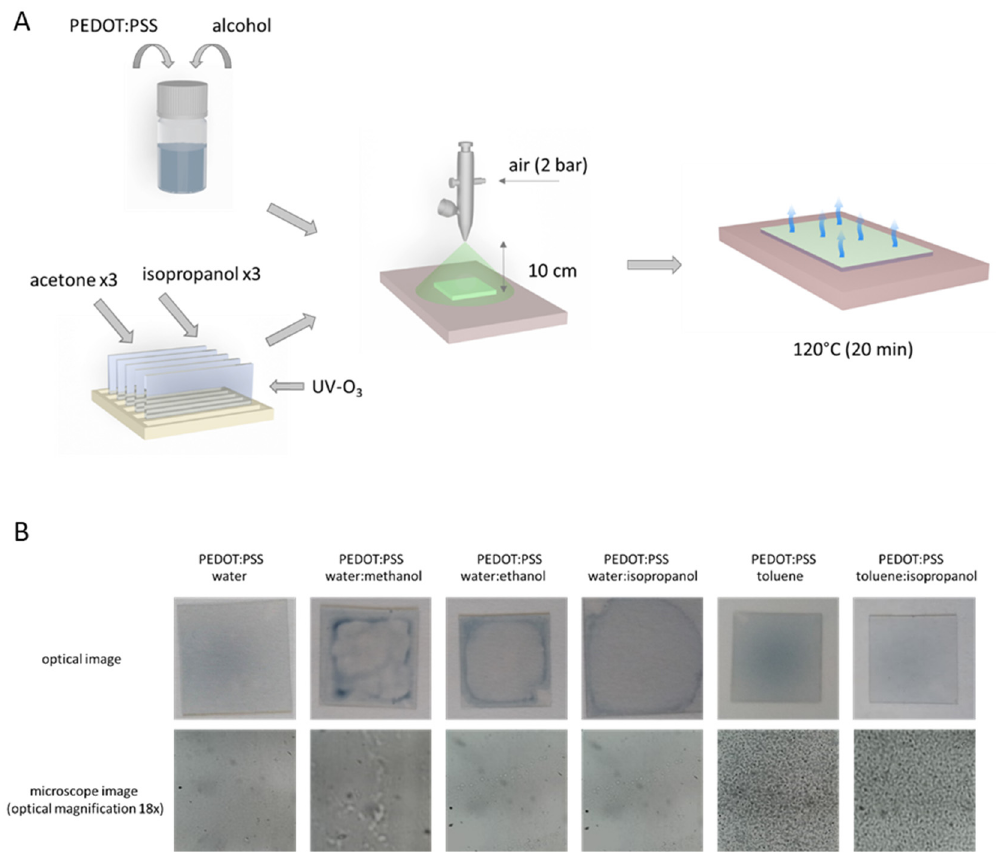
Figure 4. Scheme of layer preparation using spray coating technique ( A ); images of PEDOT:PSS layers (spray coated, 10 cm distance, pressure 2 bar) and microscopic images acquired at optical magnification of 18× ( B ).